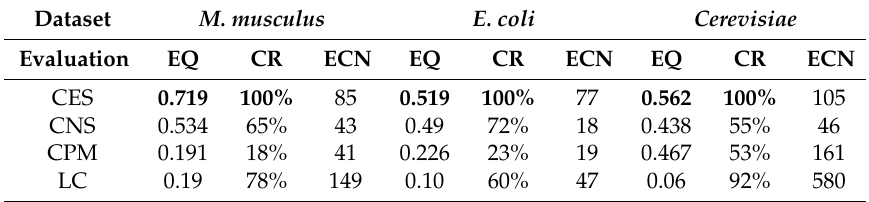
The bold numbers represent the best result among all algorithms.